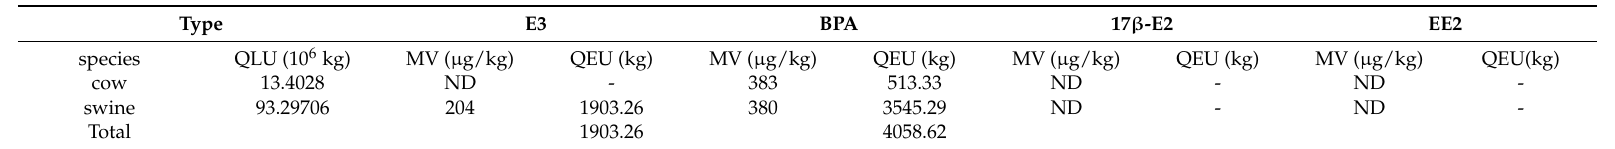
Table 6. The quantity of estrogens in livestock urine in 2014 in Jiangsu Province,